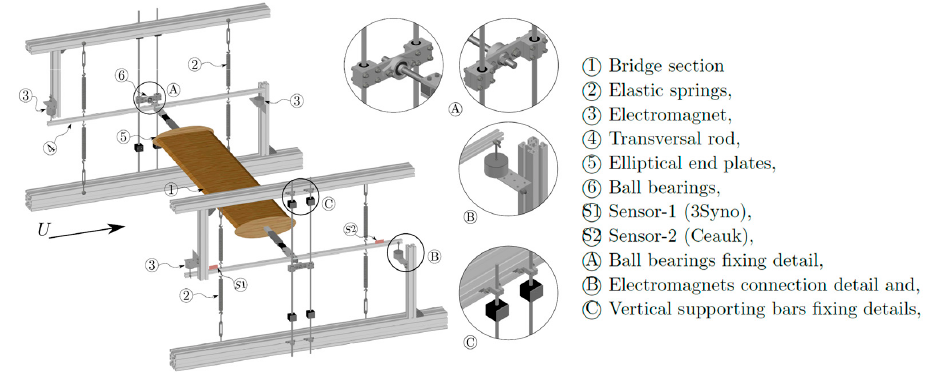
Figure 8. Three-dimensional model of test setup arrangement.